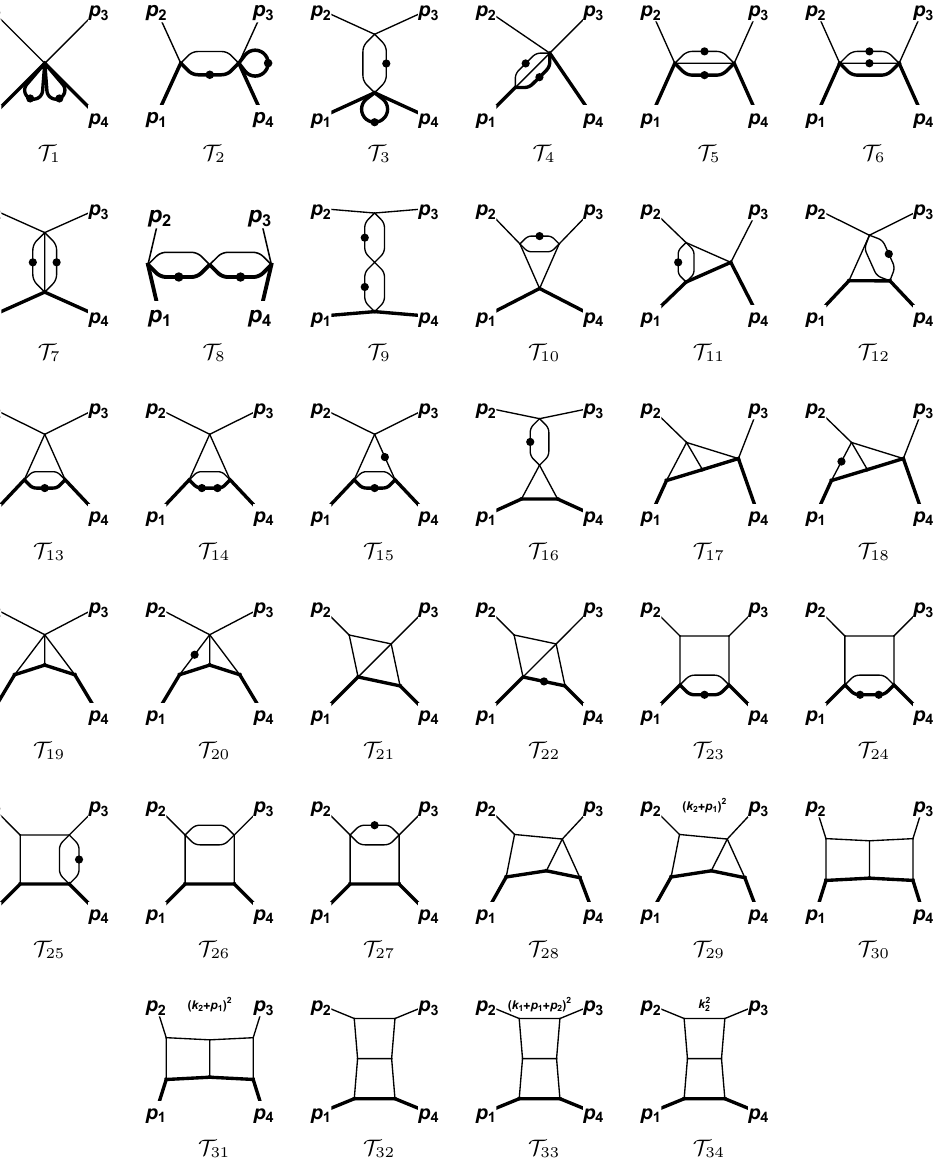
Figure 4. Two-loop MIs T